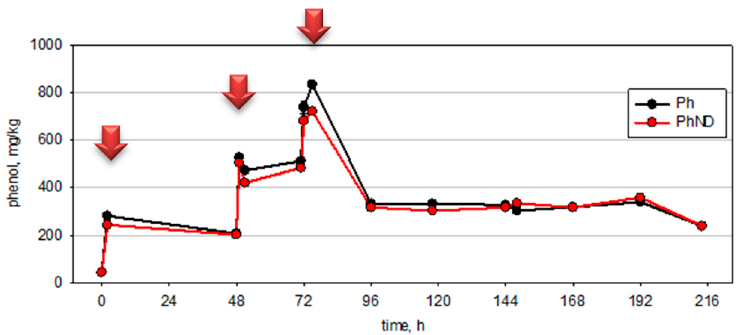
Figure 2. Residual concentration of phenol in Ph and PhND variants in the course of model bioremediation of contaminated sediments. Arrows indicate the addition of phenol in the model system—at the 2nd, 49th and 72nd hours.